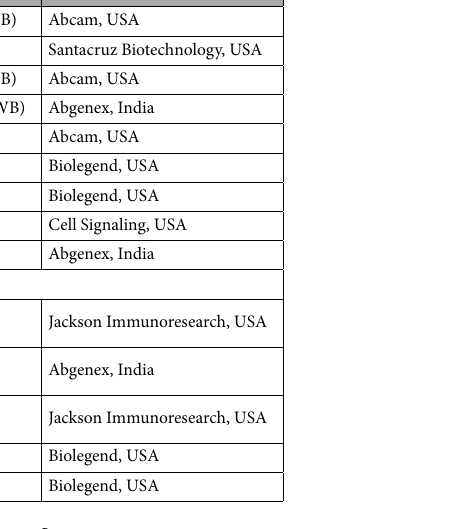
Table 2. Details of antibodies used in